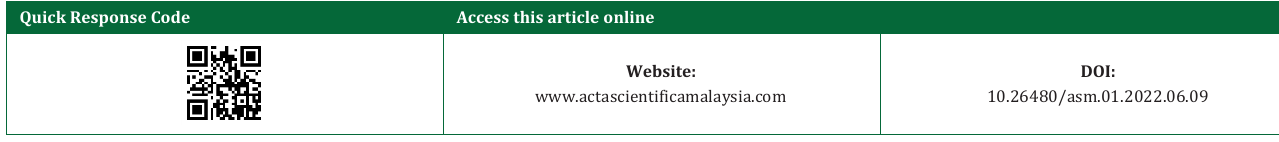
Figure 1: Curry leaves (murraya koenigii or bergera